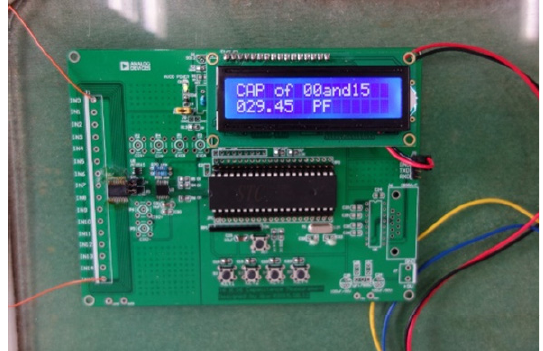
Figure 4. Circuit board for capacitance measurement and communication.